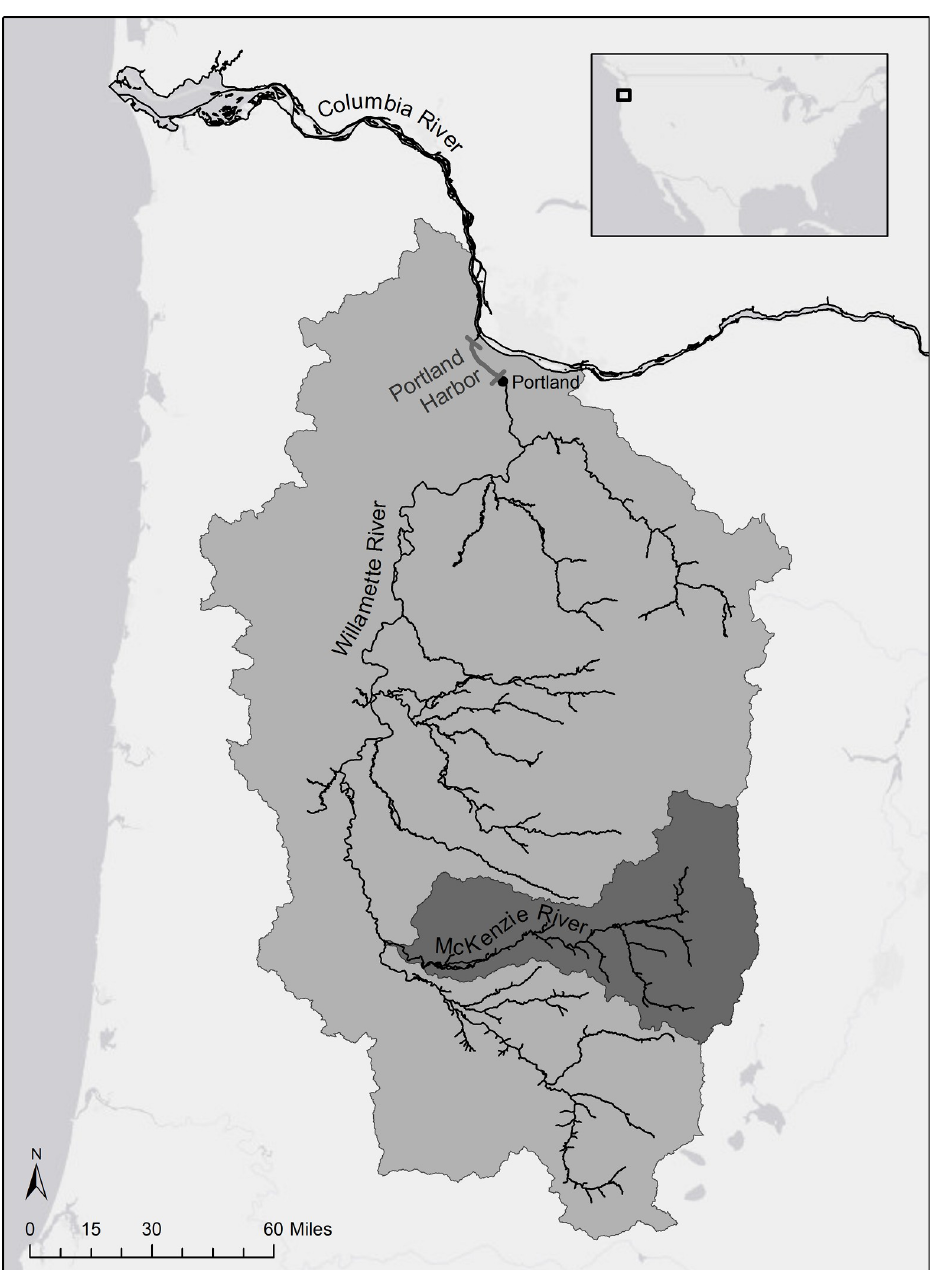
Fig 1. Map of McKenzie River watershed within Willamette River basin. Portland Harbor is bounded by grey dashes. https://doi.org/10.1371/journal.pone.0214399.g001 PLOS ONE | https://doi.org/10.1371/journal.pone.0214399 March 22,